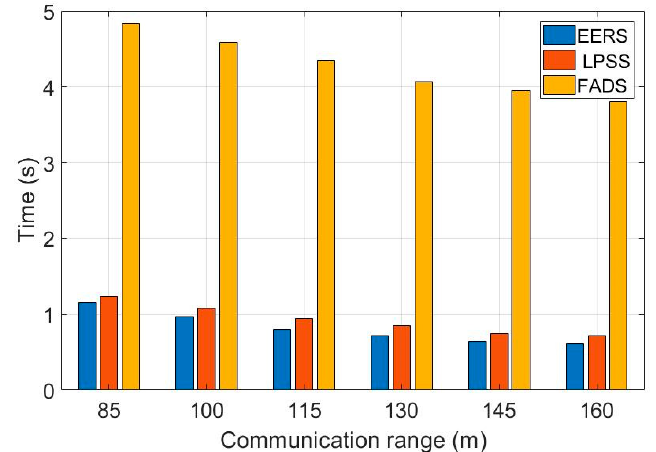
= 85 m: 160 m, N = 240).